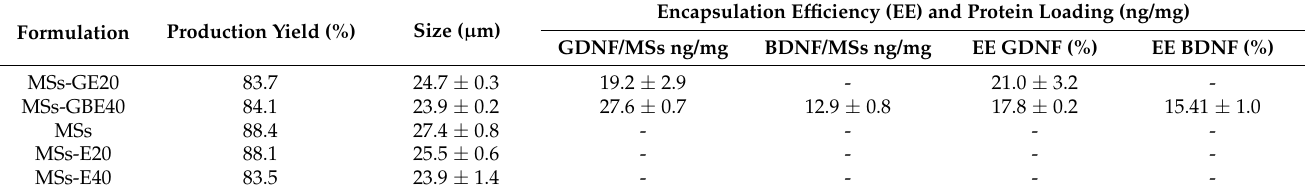
Table 1. MSs characterization in terms of production yield, mean particle size and neurotrophic factor (NTF) loading and encapsulation efficiency expressed as ng of protein per mg of MSs and as percentage of the initial number of proteins for microspheres preparations, respectively. Blank MSs (MSs); MSs/VitaminE(20) (MSs-E20); MSs/VitaminE(40) (MSs-E40);